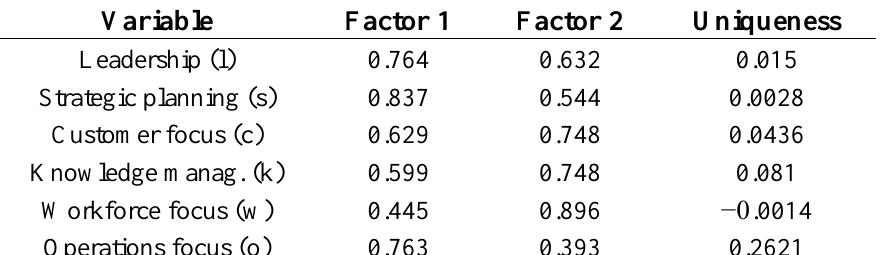
Table 7. Varimax rotation retaining two main factors.